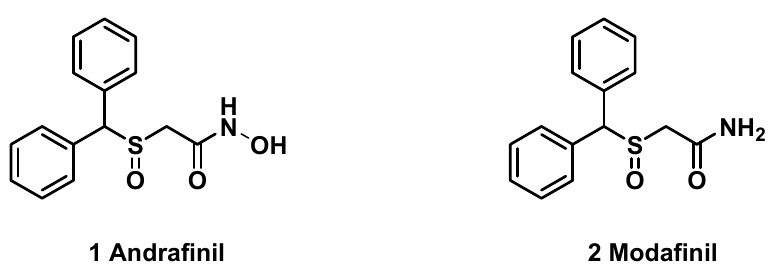
Figure 1. Structures of andrafinil 1 and modafinil 2